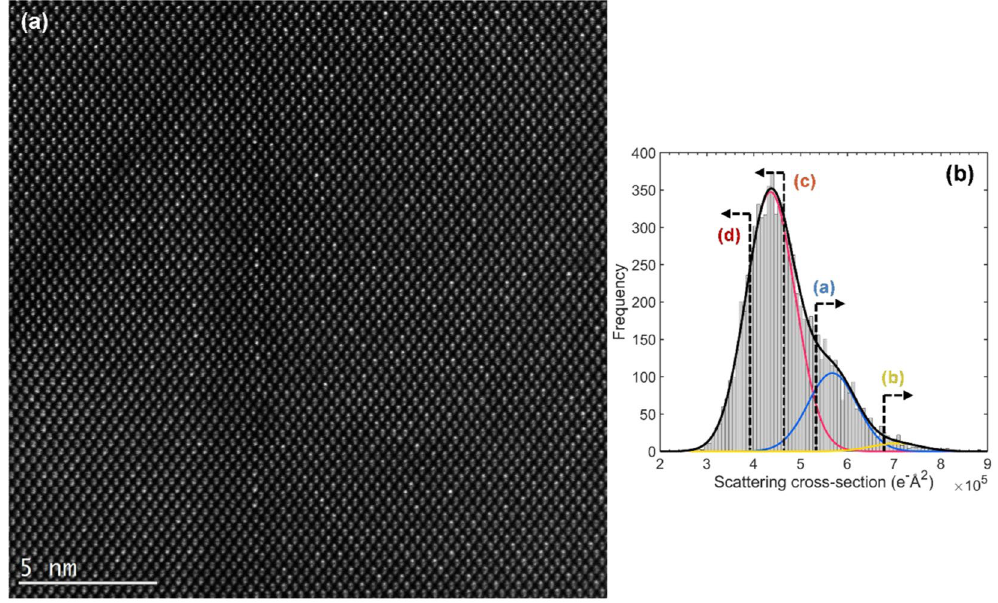
Figure 2. ( a ) Atomic-resolution HAADF image of a typical asymmetric triangular APD near its vertex. For crystallographic directions refer to Fig. 1(a). Note the reversal of atomic-dumbbell polarities in the interior of the APD. ( b ) A histogram of atomic-column scattering cross-sections (SCS) in Fig. 2 ( a ). The SCS distribution is tentatively fitted with three Gaussians. Vertical dashed lines with arrows refer to various SCS distributions mapped in Fig.